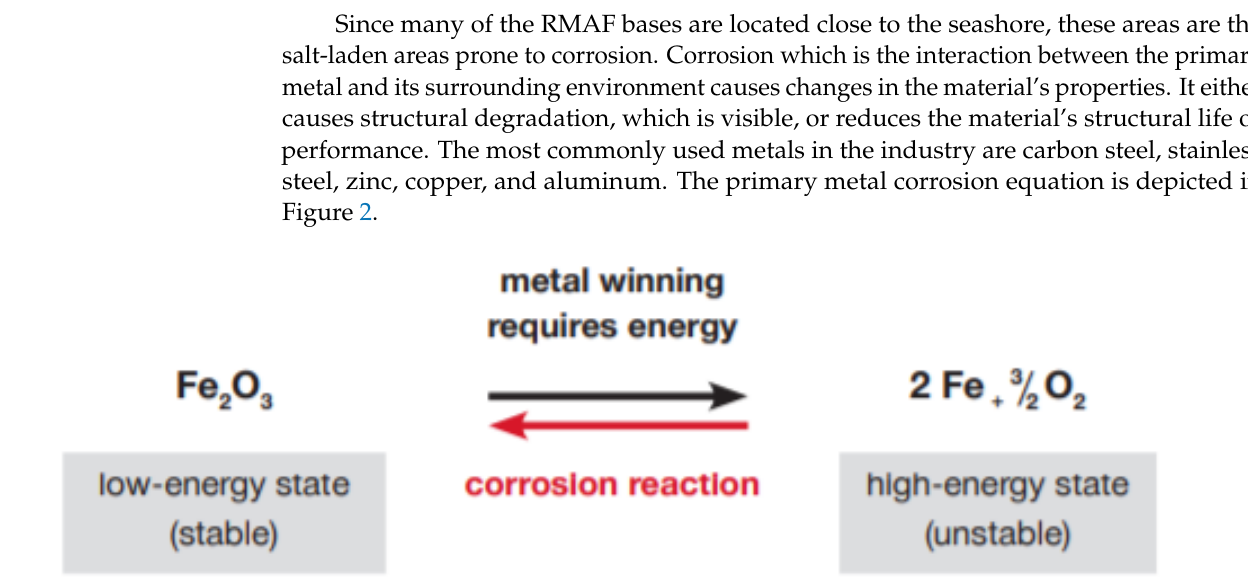
Figure 2. Chemical reactions of iron during corrosion and the metal-winning process [12].